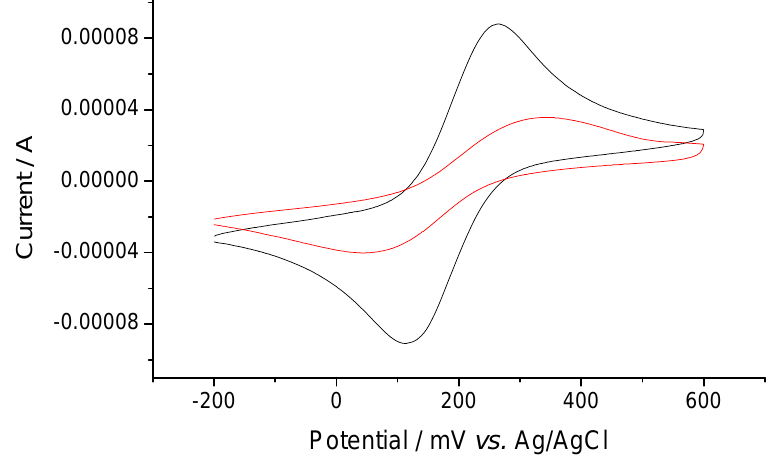
Fe(CN) + 0.2 M KCl at a scan rate of 100 3 6